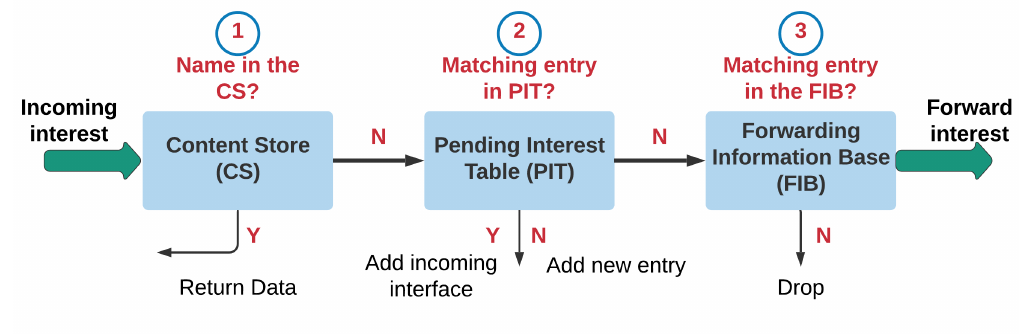
Figure 1. Interest packet forwarding process.